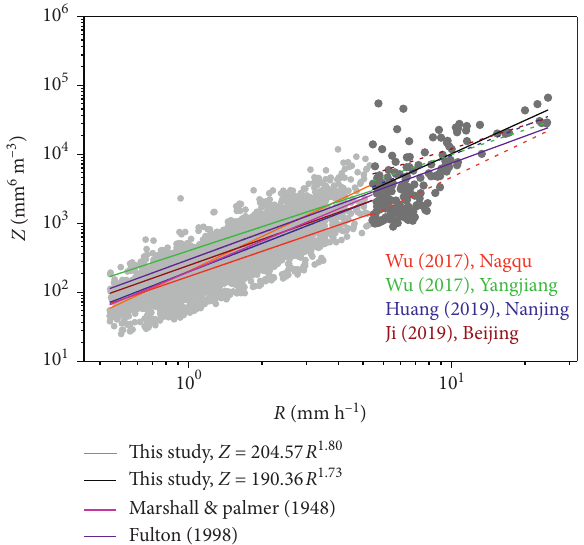
Figure 10: Scatterplots of Z − R values for convective rain (dark gray dots) and stratiform rain (light gray dots). The fitted power- law relationships of convective and stratiform rain in the form of Z � A · R b are shown in orange and black solid lines, respectively. The magenta solid line denotes the continental stratiform rain relation reported by Marshall and Palmer [59]. The purple solid line denotes the default NEXRAD relation reported by Fulton et al. [60]. The red, green, blue, and wine red lines represent the Z − R re- lations obtained in previous studies by Wu et al. [63], Wu et al. [63], Huang et al. [62], and Ji et al. [64] for different parts of China. The different line types represent different rains: solid lines for strat- iform rains, and dashed lines for convective